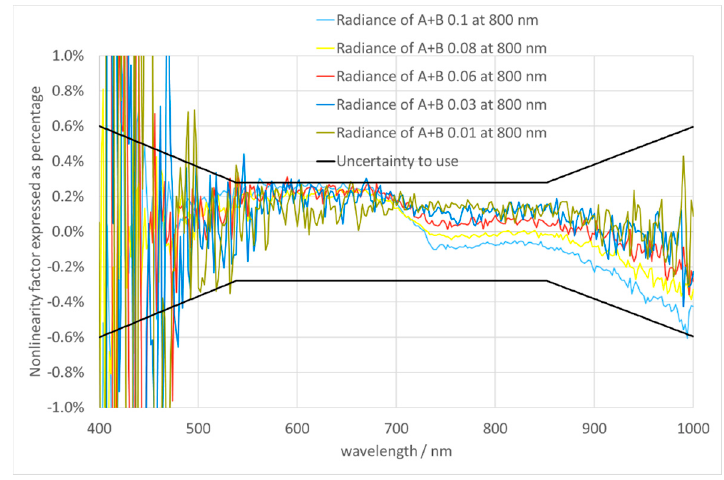
Figure 6. Nonlinearity factor obtained for five different radiance levels (radiance levels in legend are in units W m -2 sr -1 nm -1 at 800 nm).